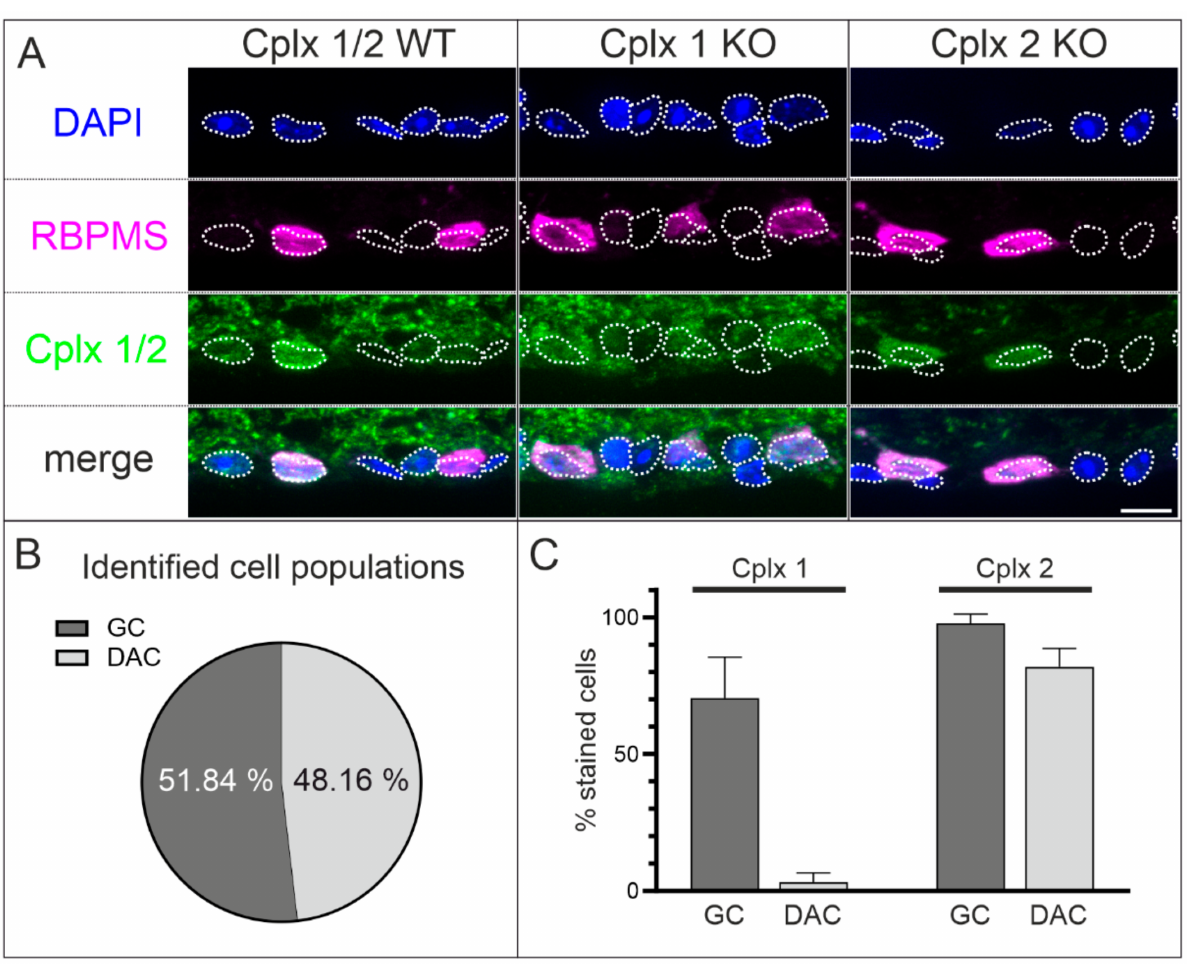
Figure 8. Expression of Cplx 1 and Cplx 2 in ganglion cells (GC) and displaced amacrine cells (DAC) in the ganglion cell layer (GCL) in mouse retinae. ( A ) Fluorescence micrographs of vertical cryostat sections through retinae of wildtype (WT) and Cplx 1 and Cplx 2 knockout (KO) mice triple labeled with DAPI and antibodies against the RNA-binding protein with multiple splicing (RBPMS; GC) and Cplx 1/2. White dotted lines outline DAPI-positive nuclei. ( B ) Identified cell populations of GC and DAC. ( C ) Quantification of the Cplx 1- and Cplx 2-positive GC and DAC somata. Sum of all stained cell somata = 100%; number of analyzed cells for ( B ) 521 GC and 484 DAC and ( C ) 248 GC and 247 DAC for Cplx 2 KO, and 273 GC and 237 DAC for Cplx 1 KO. Bar graphs display the mean percentages ± SD in three animals per genotype. Scale bar = 10 µ m in ( A